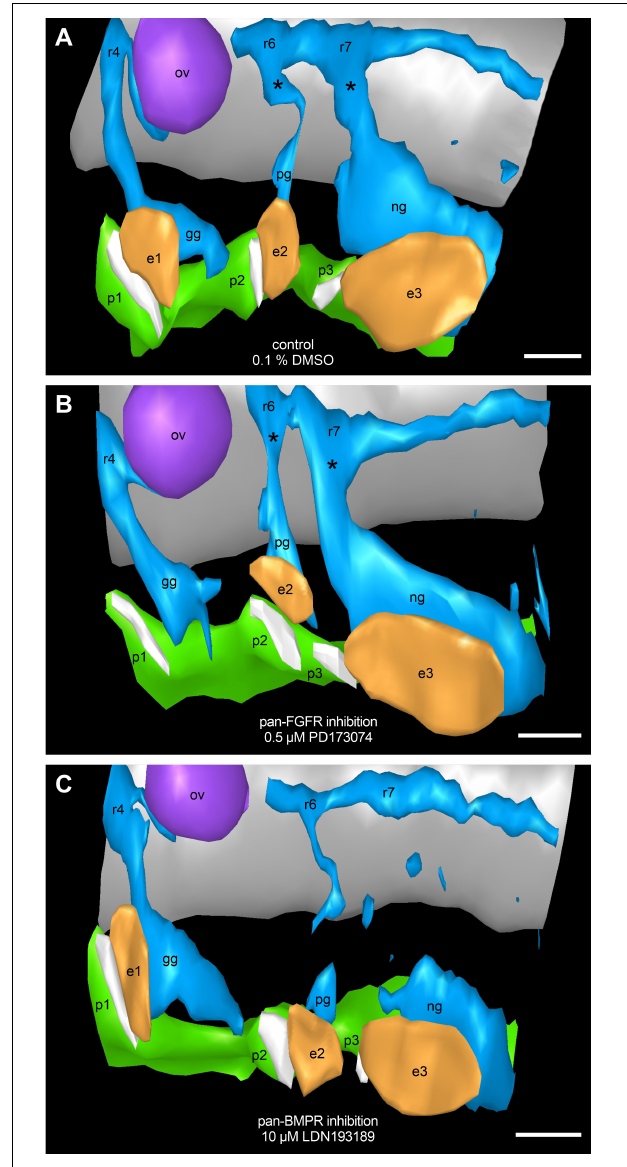
FIGURE 9 | Assessment of potential FGF and/or BMP dependencies of neural crest streams emerging segmentally from the rhombomeres 4, 6, and 7. 9–14 somite mouse embryos, cultured for 24 h. Our 3D reconstructions show that neural crest streams (blue) emerge from rhombomeres 4, 6, and 7 (r4, r6, and r7), and give rise to the proximal ganglia (asterisks) of the cranial nerves IX and X as well as to the geniculate, petrosal, and nodose ganglia (gg, pg, and ng) both in DMSO control embryos (A) and after exposure to 0.5 µ M of the pan-FGFR inhibitor PD173074 (B) . Treatment with 10 µ M of the pan-BMPR inhibitor LDN193189, like genetic silencing of the BMP pathway (Kanzler et al., 2000), leads to the partial loss of neural crest streams and proximal ganglia originating from r6 and, to a greater extent, r7 (C) . In at least some of the PD173074 treated embryos (for details, see text), pharyngeal pouches 2 and 3 as well as branchial membranes 2 and 3 have approached each other beyond the normal level. Also note loss of ectodermal thickening in the position of epibranchial placode 1. e1, e2, e3, epibranchial placodes 1, 2, and 3 (orange); ov, otic vesicle (purple); p1, p2, p3, pharyngeal pouches 1, 2, and 3 (green); white stripes adjacent to the epibranchial placodes, branchial membranes 1, 2, and 3; gray, hindbrain. Scale bars: 100 µ